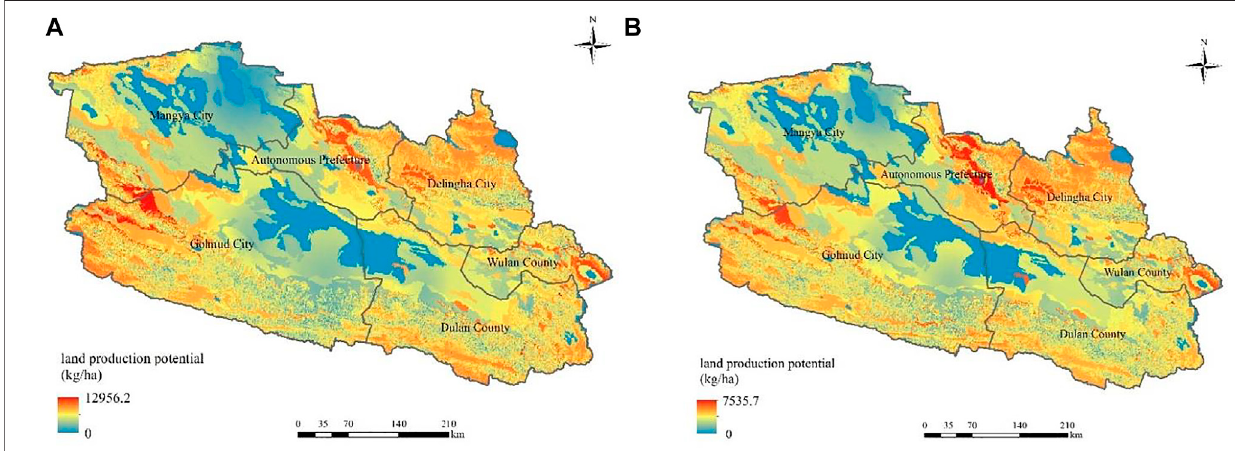
FIGURE 7 | Land production potential of spring wheat (A) and highland barley (B) .